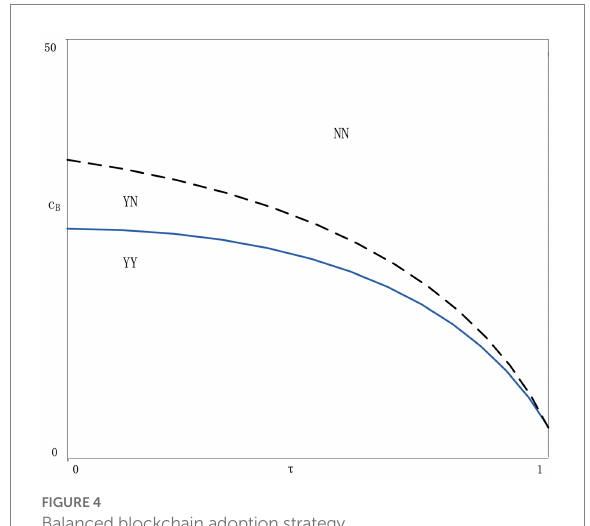
FIGURE 4 Balanced blockchain adoption strategy. FIGURE 5